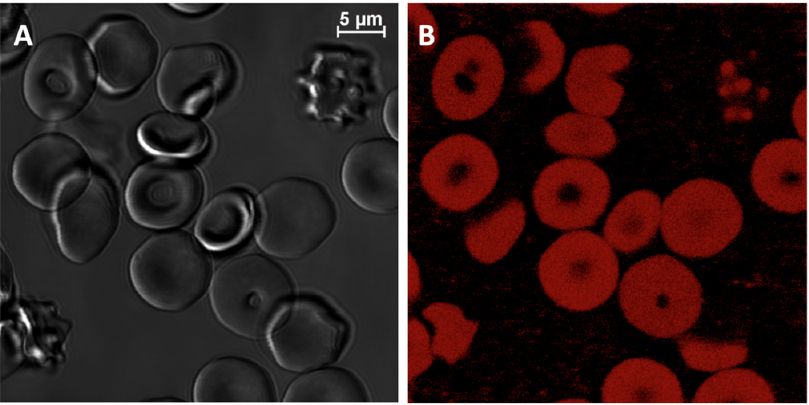
Figure 2. Transmission and confocal fluorescent microscopy imaging of RBCs stained by lipophilic fluorescence dye PKH26; ( A ) transmitted light image; ( B ) laser confocal image ( λ exc = 532 nm; λ det = 567